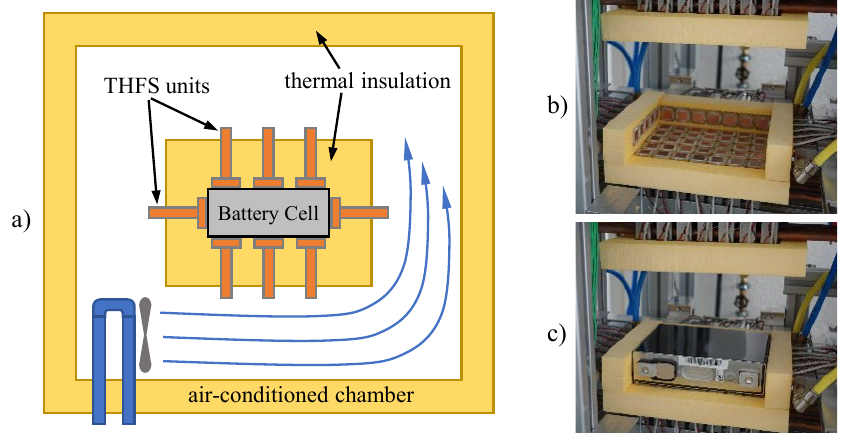
Figure 1. Schematic drawing ( a ) of the used experimental setup on the left, with an insulated battery cell placed inside the air-conditioned chamber. On the right hand side two photographs of the THFS units before ( b ) and after ( c ) the installation of a battery